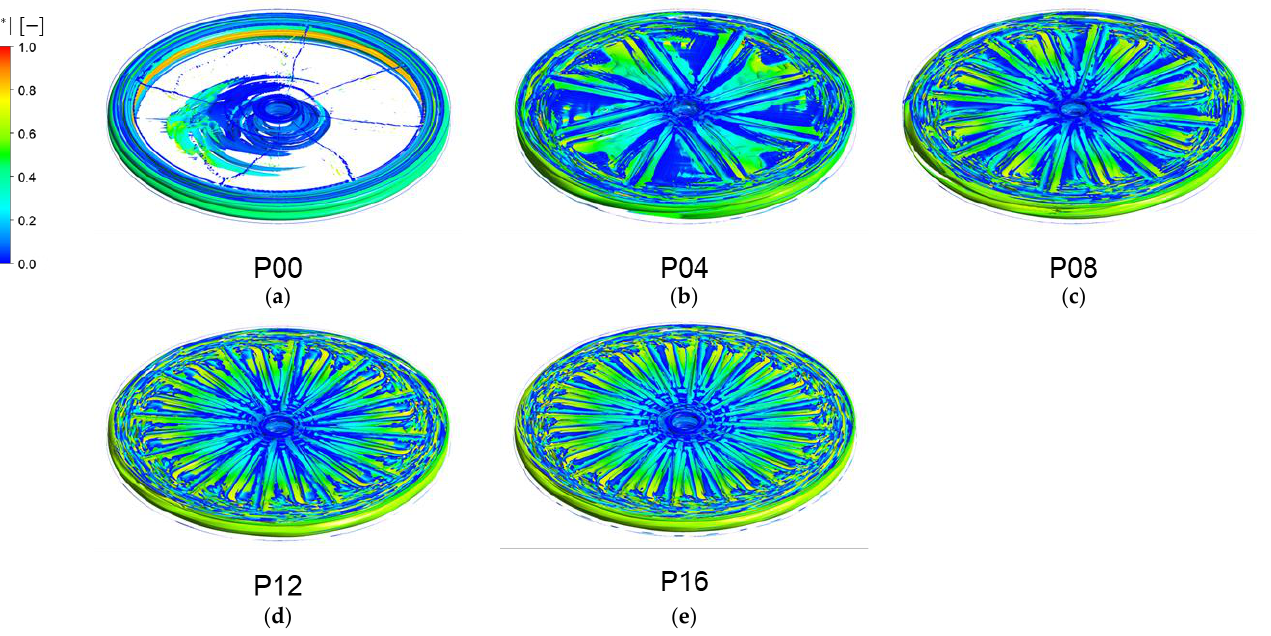
Figure 8. The vortex structures affected by the number of patterns 𝑁 𝑝 , visualized by 𝜆 2 -criterion when the angular velocity of the disk is 𝛺 = 200 rpm . The color contour in each plot represents the dimensionless velocity magnitude ( |𝐮 ∗ | ). (a) 𝑁 𝑝 = 0 (plain disk), (b) 𝑁 𝑝 = 4 , (c) 𝑁 𝑝 = 8 , (d) 𝑁 𝑝 = 12 , and (e) 𝑁 𝑝 = 16 .